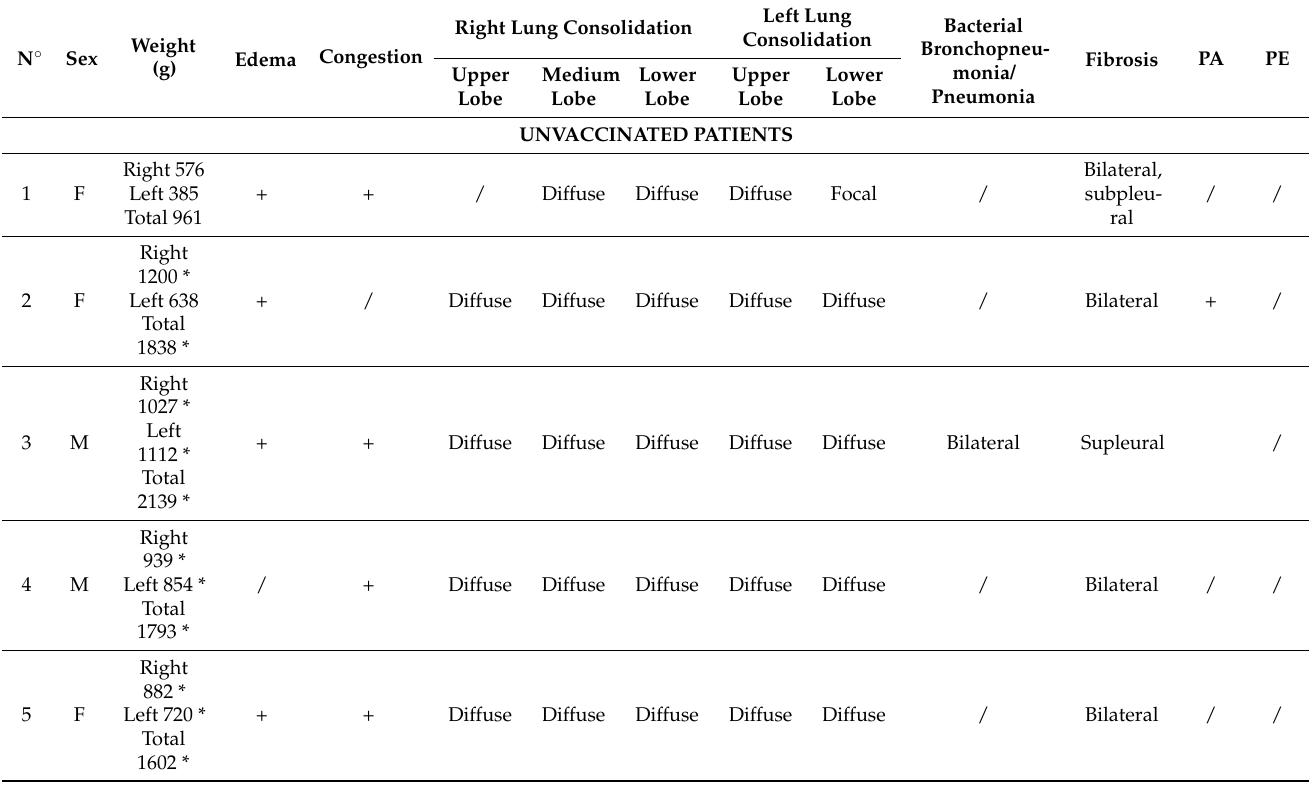
Table 4. Macroscopic lung